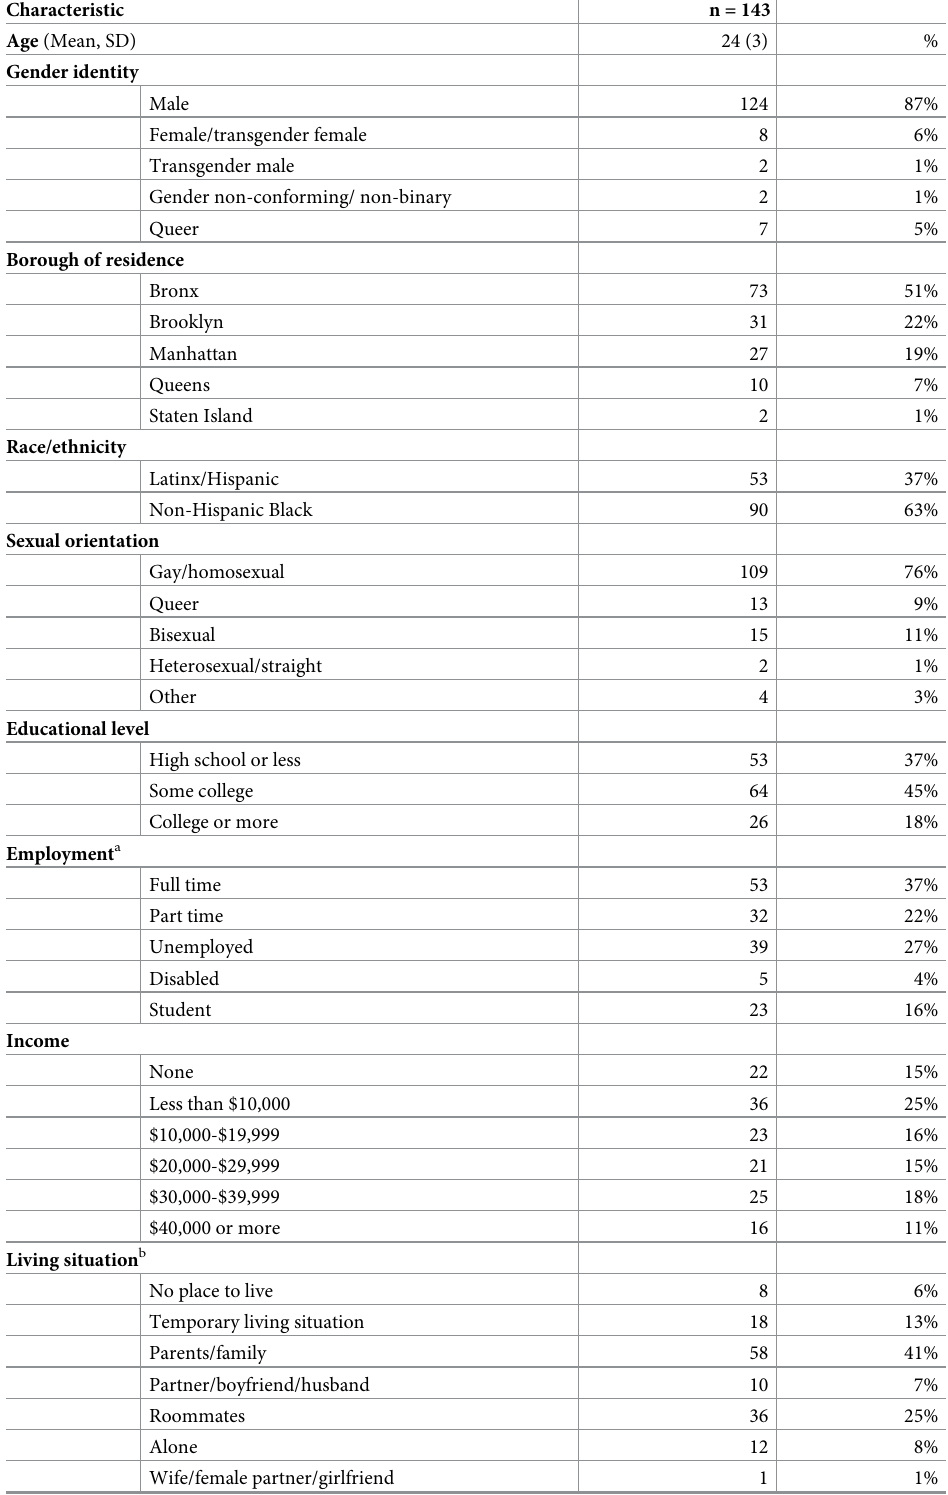
Table 1. Sociodemographic characteristics (n =